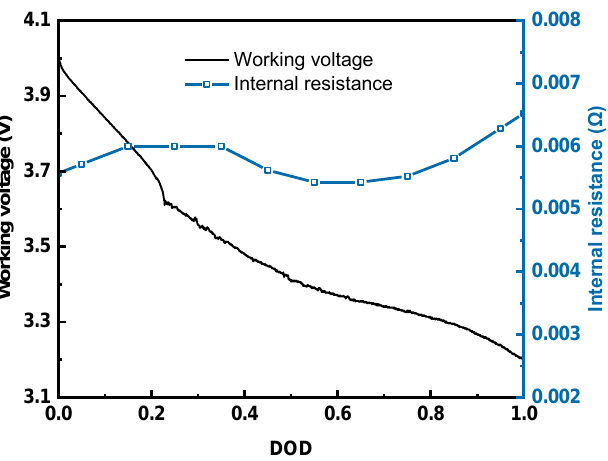
Figure 11. The working voltage and internal resistance curve (Temperature: 25 °C, C-Rate: 0.5C). The output power of the entire discharge process of the battery pack under multiple WLTCs can be expressed by Equation (19):